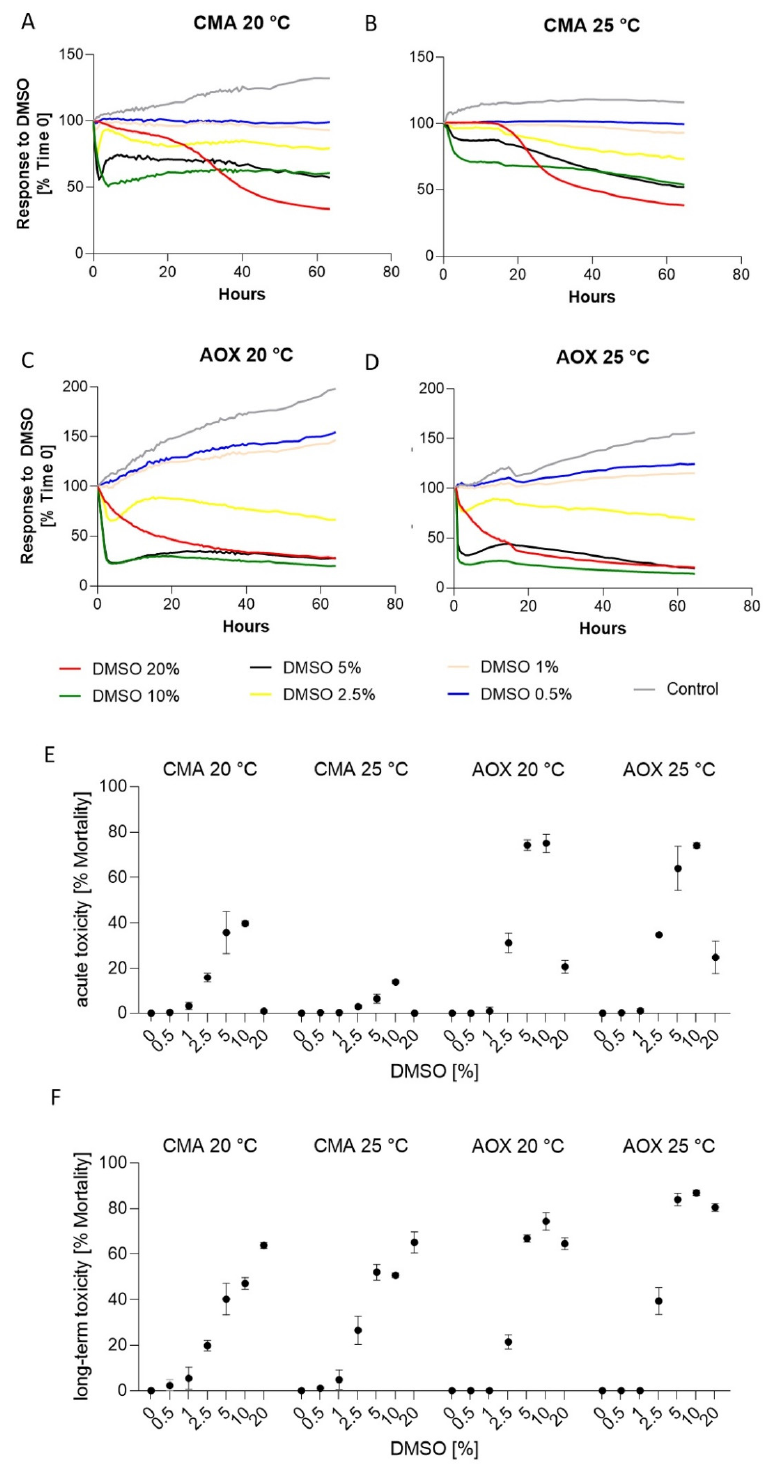
Figure 5. Response of CMAfin1 ( C. maraena ) and AOXlar7y ( A. oxyrinchus ) cells on DMSO addition under 20 and 25 ◦ C cultivation. ( A – D ) Visualization of growth curves over time (% confluence) at different DMSO concentrations (20%—red, 10%—green, 5%—black, 2.5%—yellow, 1%—beige, 0.5%—blue, control; 0%—grey). ( E ) Calculated acute toxicity (% mortality compared to the initial confluence value) and ( F ) long-term toxicity (% mortality compared to the initial confluence value) from 4 replicates per experimental